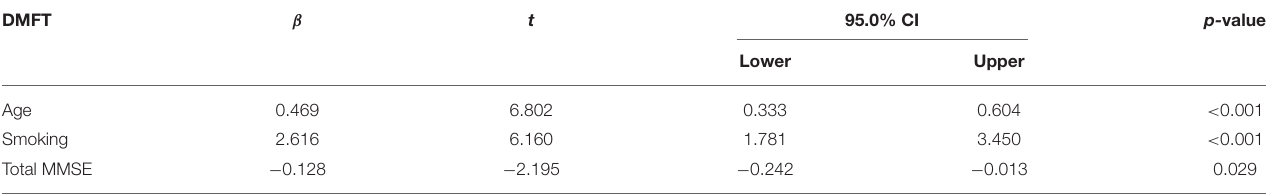
TABLE 4 | Linear regression model of DMFT in elderly schizophrenia inpatients.